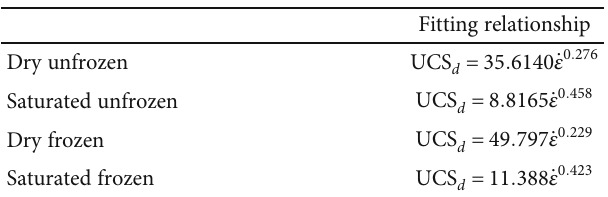
Figure 8: Variations in UCS d against strain rate under four Table 3: Fitting parameters of the relationship between dynamic strength and strain rate.